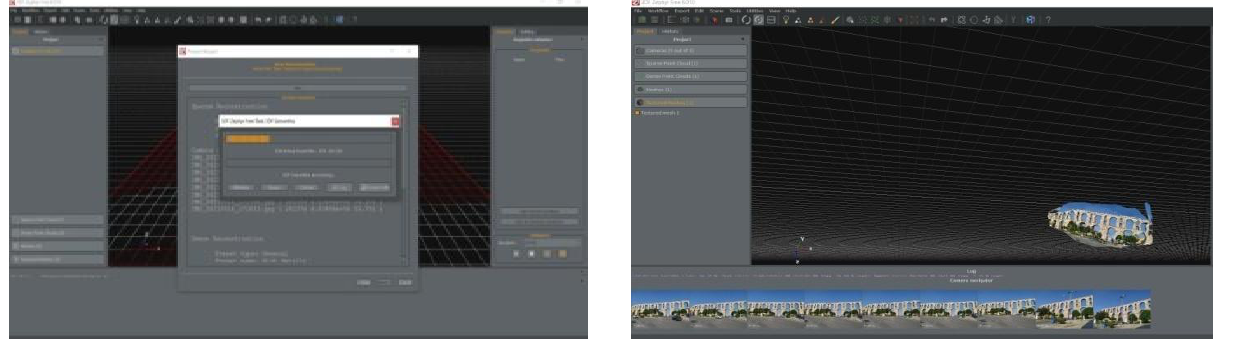
Figure 7. The Progress of Modelling